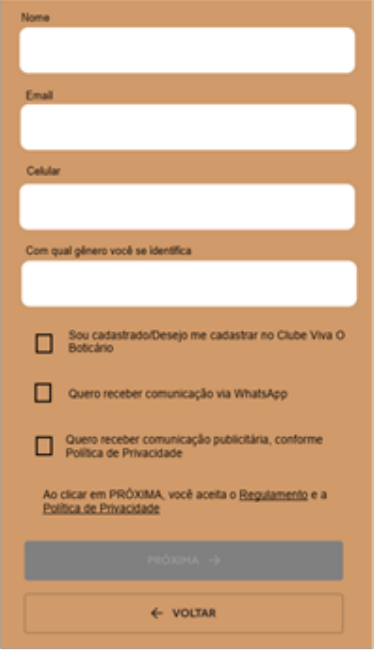
Figure 3. Entry page for other identification and communication data.